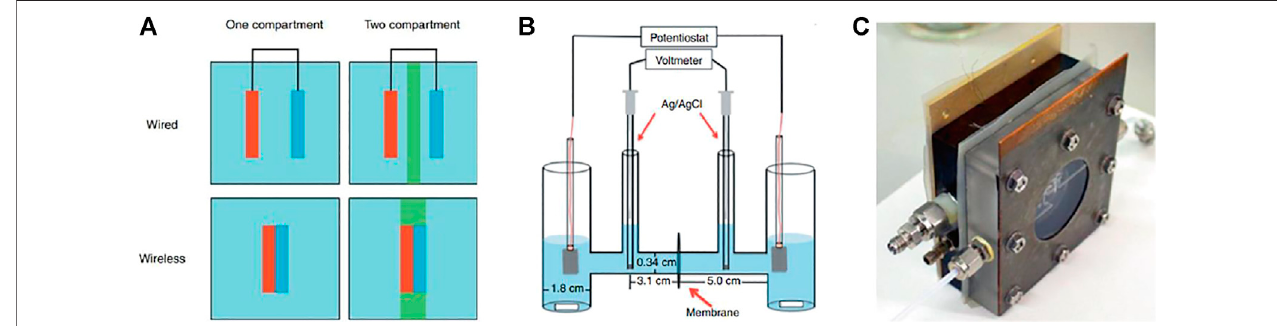
FIGURE 3 | (A) Schematic illustration of wired and wireless con fi gurations in one- and two-compartment PEC cells. Reprinted from Bosserez et al. (2015). Copyright 2012 EDP Sciences. (B) H-type glass chamber for PEC H 2 and O 2 evolution.Reprinted (adapted) with permission from Hernández-Pagán et al. (2012). Copyright2012RoyalSocietyofChemistry. (C) DualcompartmentPEC cellwithSEA,in-,and outletconnection.Reprinted from Bosserezet al.(2015).Copyright2012 EDP